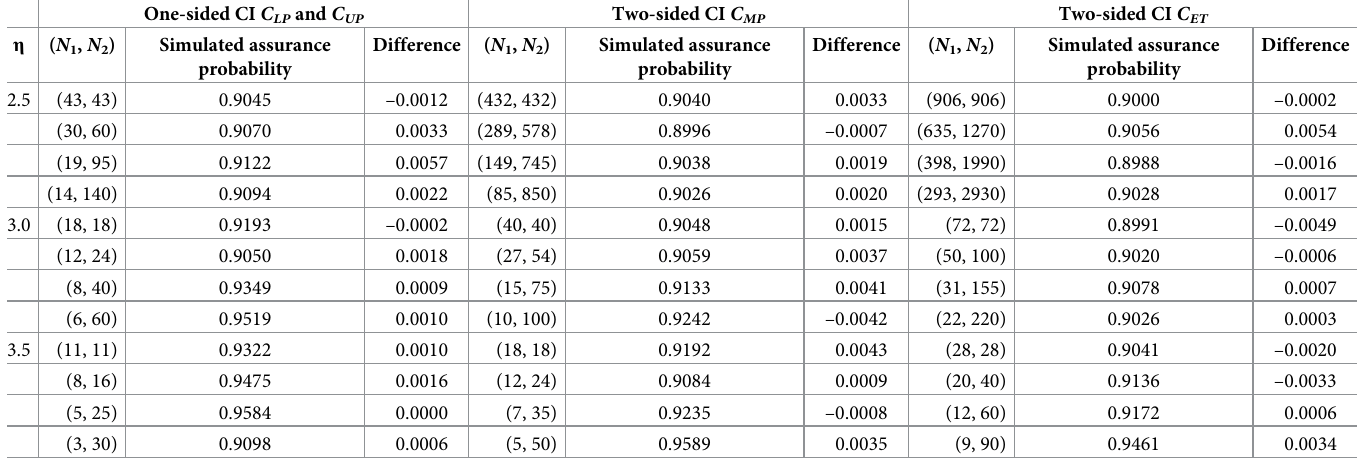
Table 7. The computed sample size, simulated assurance probability and errors for the 95% reference intervals of the distribution proportion 0.90 with assurance probability 0.90. One-sided CI C and C LP UP η ( N 1 , N 2